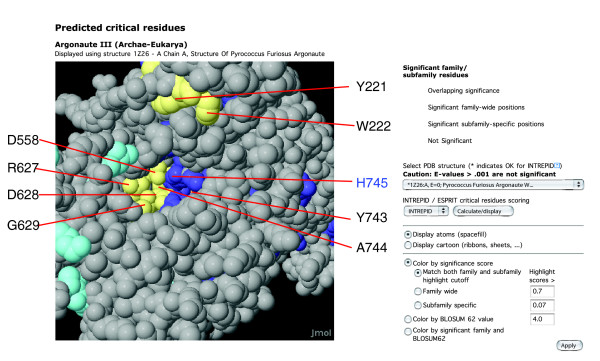
Key residue prediction using SCI-PHY subfamily-specific and family-wide conservation patterns. Shown above is the PDB structure for the Pyrococcus furiosus Argonaute protein (PDB structure 1Z26A), from the PhyloFacts book Argonaute III (Archaea-Eukarya). The structure has been colored to predict functional residues. Residues colored yellow are conserved within both subfamilies and across the family as a whole. Positions conserved only within individual subfamilies but not across the family are colored dark blue. Positions having sufficient conservation across the family, but potentially variable within one or more subfamilies are colored light blue. These conservation patterns are predicted for each book in the PhyloFacts resource; where homologous PDB structures can be identified, these patterns are plotted on the structure. Users can modify cutoffs for determining significance using the boxes at right. Most of the residues highlighted automatically by our conservation analyses, based on the default cutoffs, have been determined experimentally to be part of the active site [80-82] (labeled manually for this figure): R627, D628, G629, D558, Y743, H745). Y221 and W222 represent a prediction by this server. Structure viewing and interaction is enabled by the Jmol software.